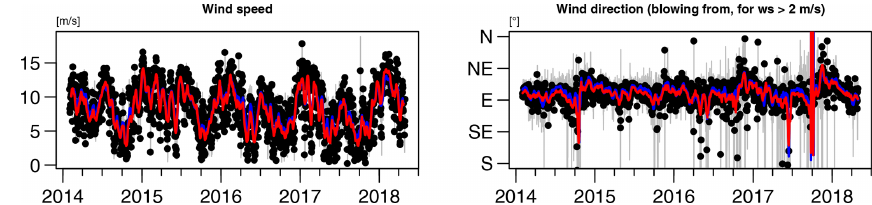
Figure 3. Meteorological conditions at Masaya volcano retrieved from the operational ECMWF reanalysis data. See Fig. 2 for